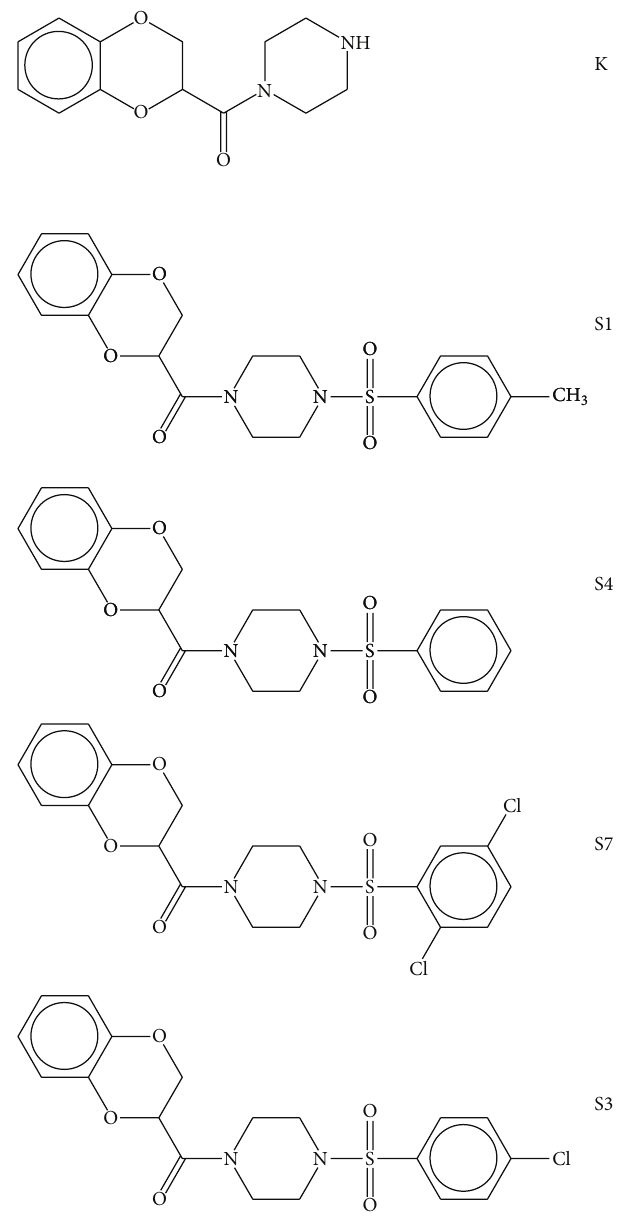
Figure 1: Ligand structures: 1-(1,4-benzodioxane-2-carbonyl) piperazine (K), 4-(4-methyl)-benzenesulfonyl-1-(1,4-benzodioxane-2- carbonyl) piperazine (S1), 4-benzenesulfonyl-1-(1,4-benzodioxane-2-carbonyl) piperazine (S4), 4-(2,5-dichloro)-benzenesulfonyl-1-(1,4- benzodioxane-2-carbonyl) piperazine (S7), and 4-(4-chloro)-benzenesulfonyl-1-(1,4-benzodioxane-2-carbonyl) piperazine